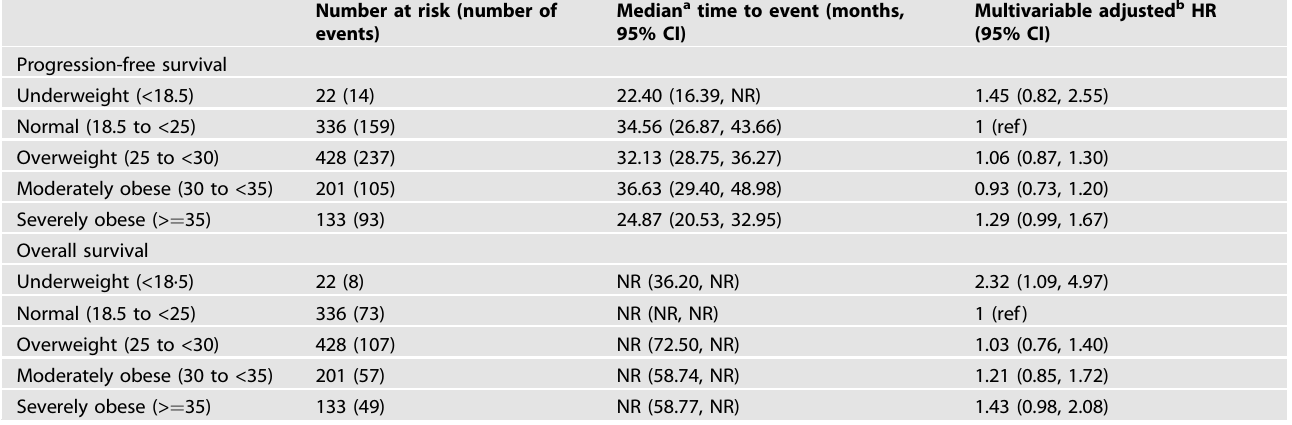
Table 2. Hazard ratios and 95% con fi dence intervals for the association of BMI with survival in newly diagnosed MM patients in the multiple myeloma research foundation CoMMpass